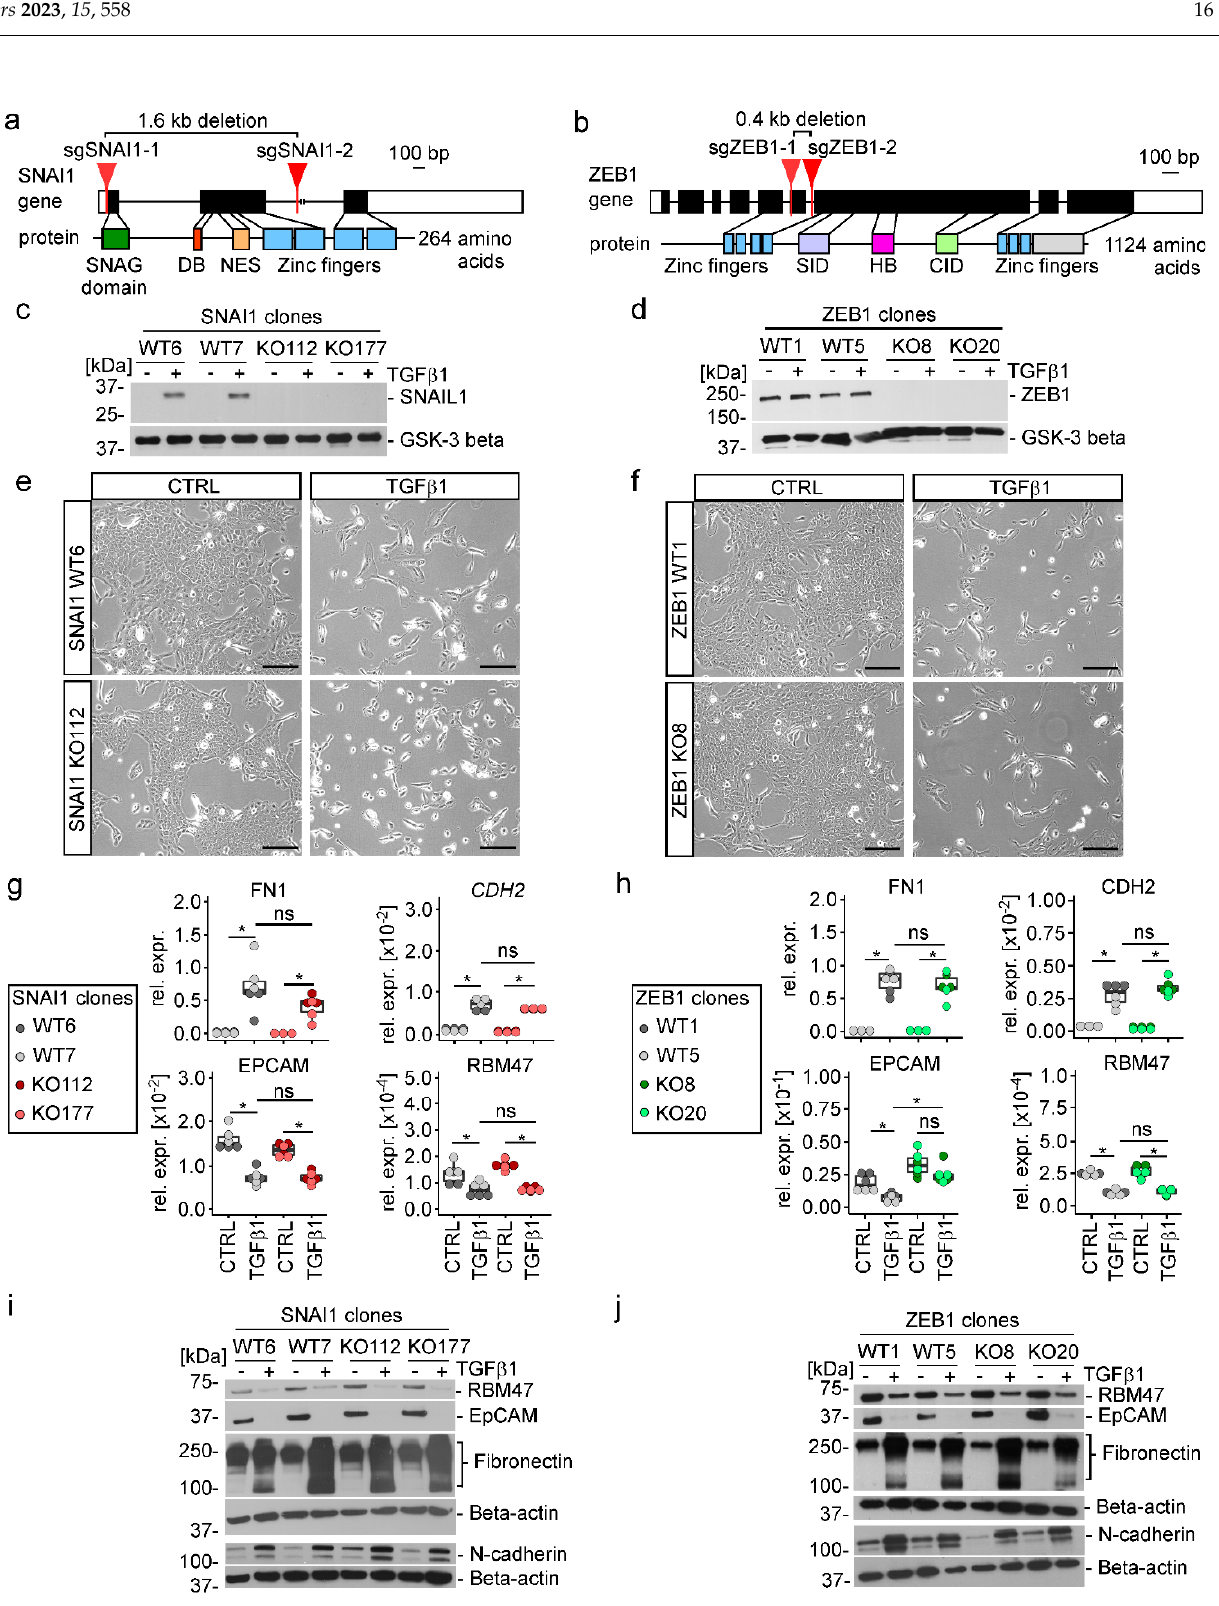
Figure 4. SNAIL1 and ZEB1 are not required for TGF β 1-induced EMT. ( a , b ) Schematic representation of the human SNAI1 and ZEB1 genes and proteins. Exons are depicted as boxes with protein-coding parts colored in black and UTRs in white. Relevant functional domains of the proteins are indicated by color and linked to the exonic region by which they are encoded. DB: destruction box; NES: nuclear export signal; SID: Smad interaction domain; HB: homeobox; CID: CtBP interaction domain. The locations of sgRNA targets used for inactivation of SNAI1 and ZEB1 are marked by red arrows. ( c , d ) Detection of SNAIL1 and ZEB1 proteins by Western blot using nuclear extracts from MCF10A SNAI1 and ZEB1 wild type (WT) and knock-out (KO) cell clones. Glycogen synthase